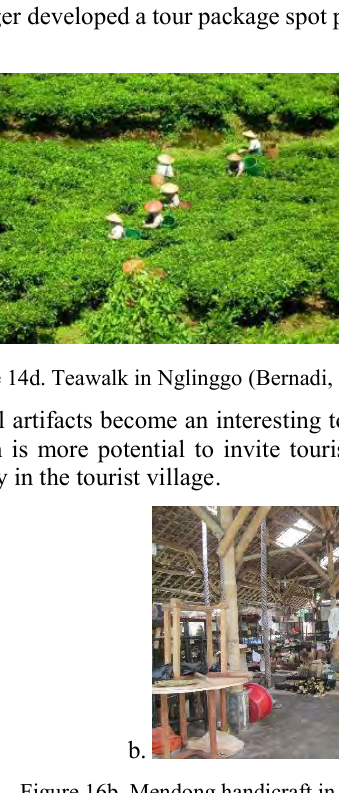
Figure 16b. Mendong handicraft in Tembi (author, 2017)